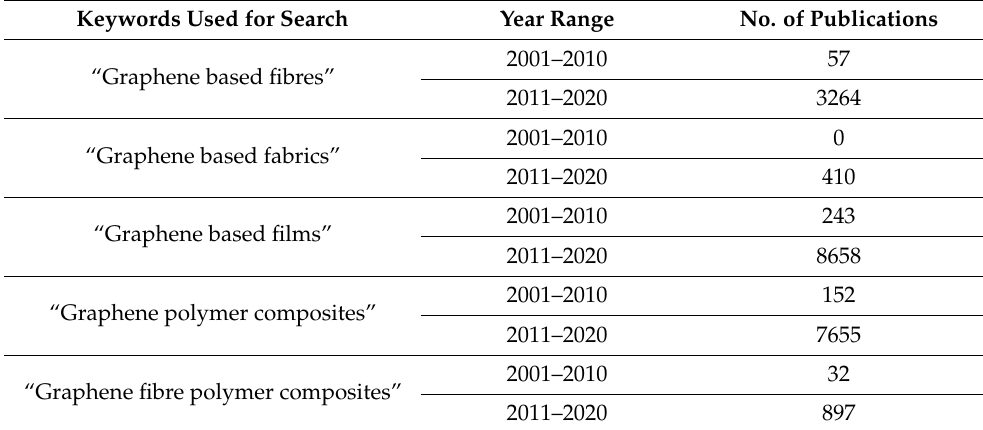
Table 1. Number of articles published between 2001 and 2020 on the graphene-based composite materials (Scopus, as of 10 September 2021).